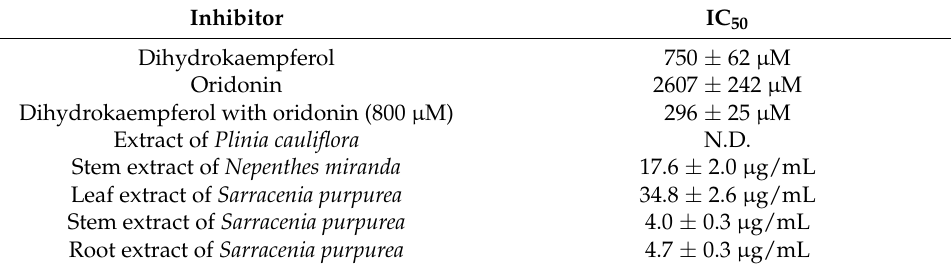
Table 2. Inhibition of the ssDNA binding activity of SaSsbA.